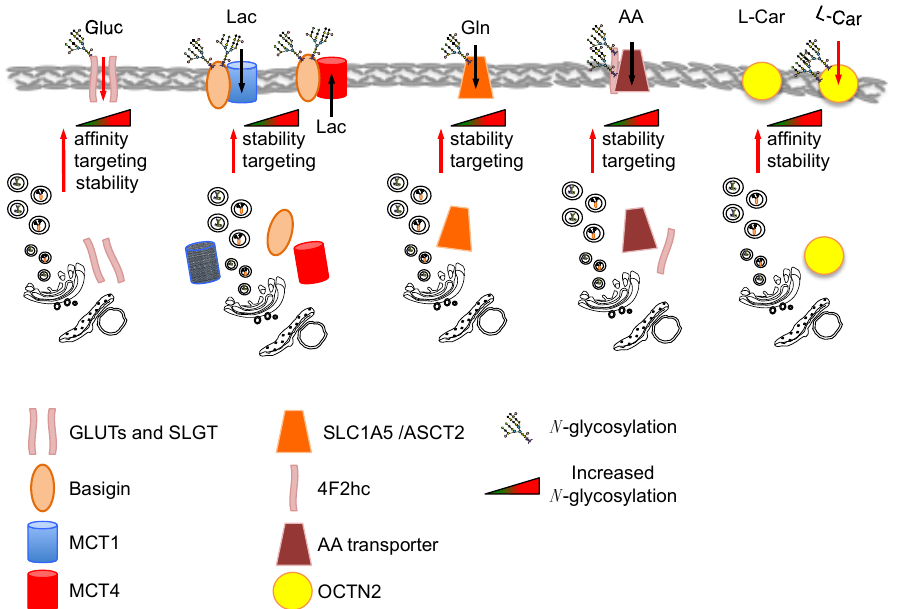
Figure 2. Schematic representation of the nutrient transporters discussed in the text. The arrows in the transporters indicate the direction of the flux. The red arrows indicate the increased nutrient transport and/or transporter affinity/targeting/stability. The single or double symbol of N -glycosylation indicates low or high glycosylated protein, respectively. The cartoon representing endoplasmic reticulum and Golgi indicates stability and targeting. Gluc: glucose; Lac: lactate; Gln: glutamine; AA: amino acid; L -Car: L